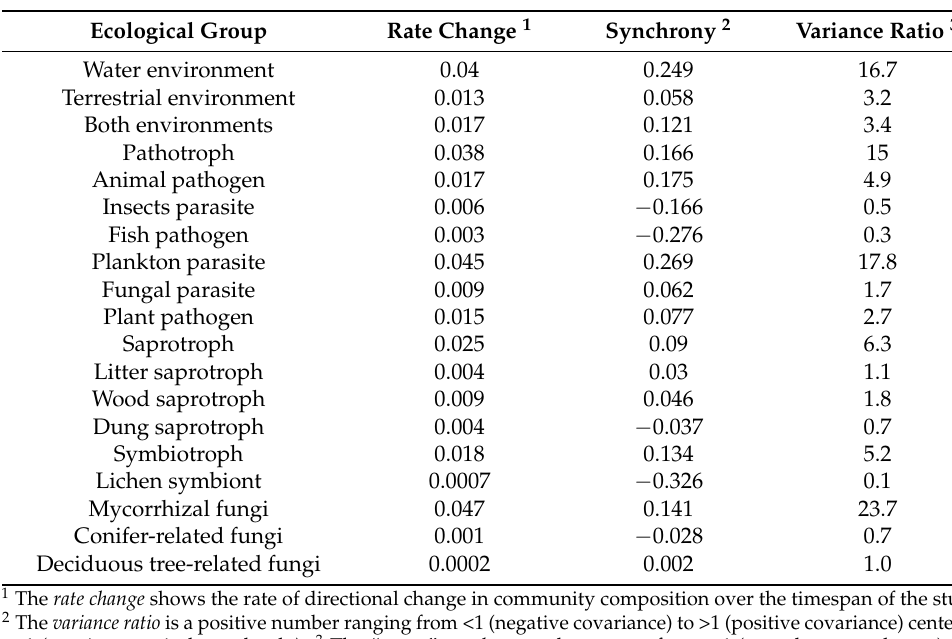
Table 1. Community change indexes of fungal groups over time.